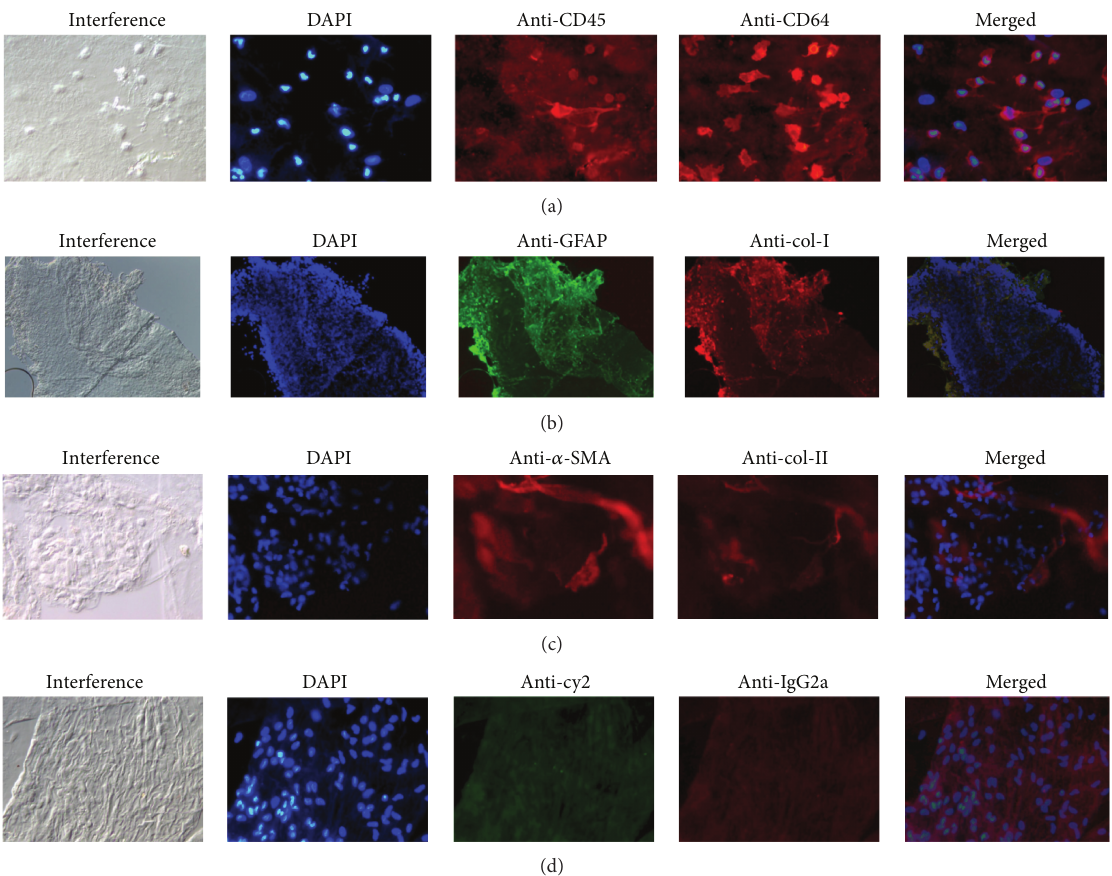
Figure 2: Interference microscopy, cell nuclei staining with 4 󸀠 ,6-diamidino-2-phenylindole, DAPI (blue), and immunocytochemical staining of lamellar hole-associated epiretinal proliferation removed from eyes with lamellar macular holes (LMH). (a) Epiretinal cells show positive immunolabelling with anti-CD45 (red) and anti-CD64 (red) in specimen removed from eyes with LMH. (b) Immunostaining of epiretinal cells seen as a thick homogenous layer positively labelled with anti-GFAP (green) and anticollagen type I (anti-col-I) (red). (c) Immunolabelling with anti- 𝛼 -smooth muscle actin ( 𝛼 -SMA) (red) and anticollagen type II (anti-col-II) (red). (d) Negative control specimen with positive cell nuclei staining but no specific immunoreactivity of cell proliferation. (Original magnification: (a) × 400; (b) × 100; (c-d) ×